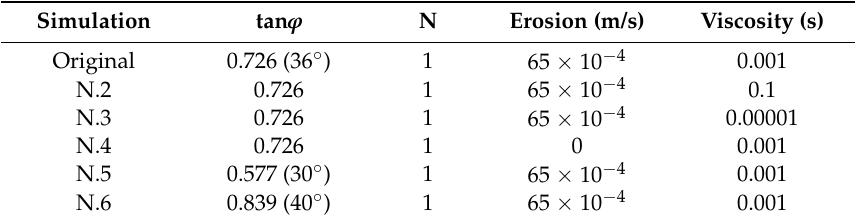
Table 3. Parameters variations for the parametric study.